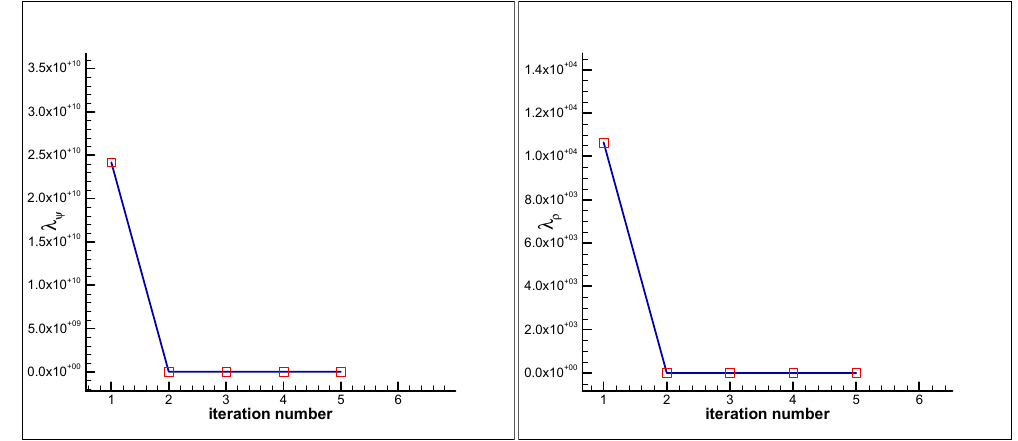
λ and λ . Figure 22. Convergence history of λ ψ and λ ρ λ and λ . ψ ρ ψ ρ